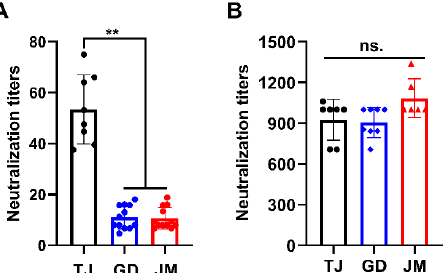
Figure 3. Antisera from pigs infected with PRV-JM isolate has broader spectrum of neutralizing ability. Neutralizing titers of antisera from classical PRV-Ea-vaccinated sows ( A ) and antisera from pigs immunized with PRV-JM isolate ( B ) against PRV-TJ, PRV-GD and PRV-JM. The significance of differences between the PRV-TJ, PRV-GD and PRV-JM were analyzed with t test. ** p < 0.01. ns., no significant